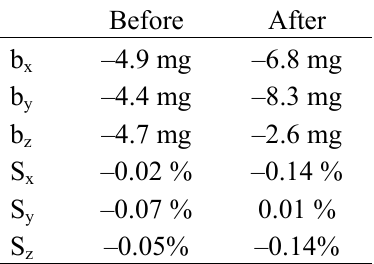
Table 6. Acceleration biases (bi) and scale factors (Si) for each axis of the IMU before and after the vibration test.